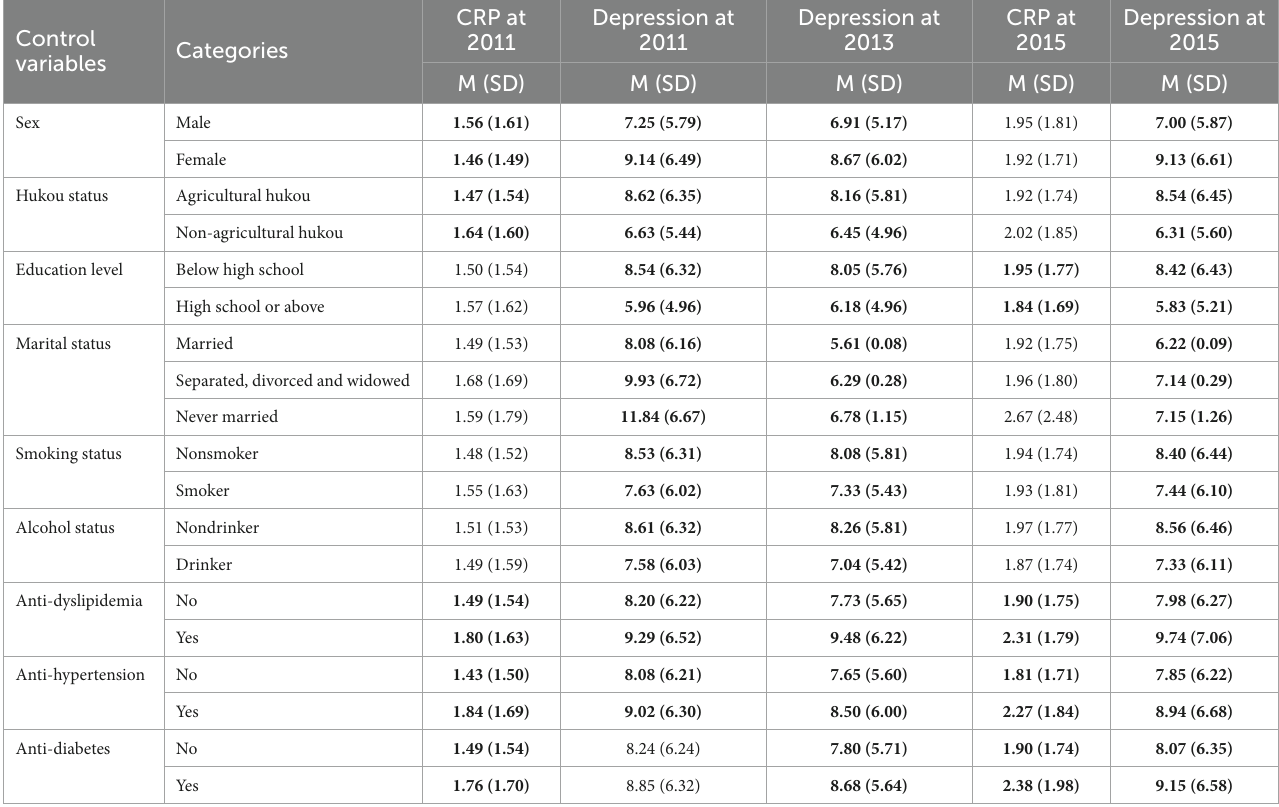
TABLE 2 The effects of categorical control variables on depression and